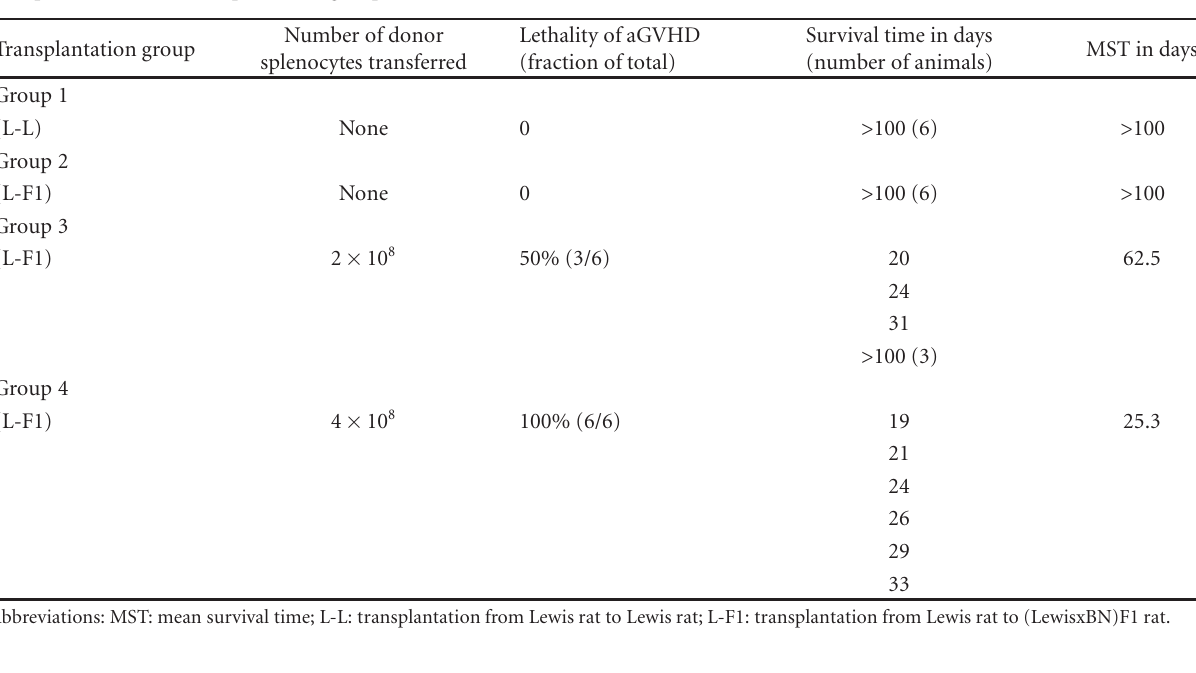
Table 1: Lethality of aGVHD, survival time of each individual animal, and mean survival time (MST) for each group following liver transplantation. Each transplantation group consisted of 6 animals.